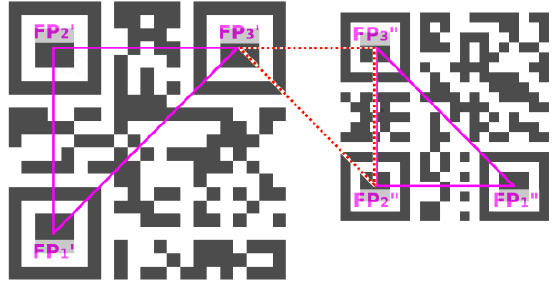
Figure 9. QR Code Figure 9. QR Code candidates.